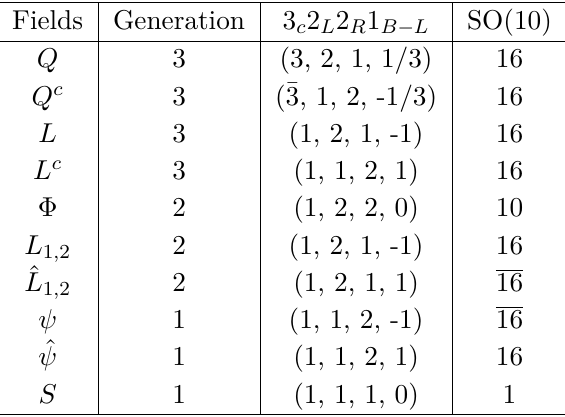
Table 2 . One of the Possible completion of the particle content under SO(10)